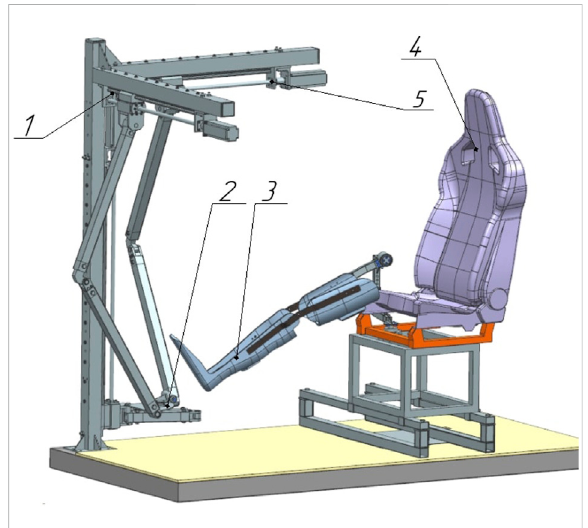
Robotic system for rehabilitation of thelower limbs. 1 — active 3-PRRR manipulator, 2 — mobile platform, 3 — passive orthosis, 4 — chair, 5 — drive